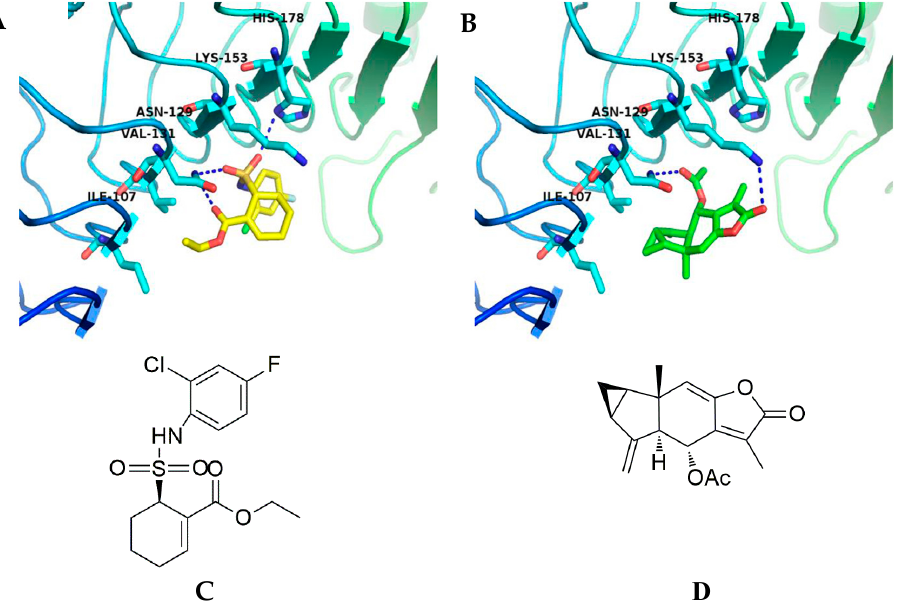
Figure 4. In silico studies to determine binding patterns of TAK-242 or 1 with TLR4. ( A ) TAK-242 (yellow) formed three hydrogen bonds with Asn129 and His178 in the binding site. ( B ) 1 (green) formed two hydrogen bonds with Asn129 and Lys153 in the binding site. Hydrogen bonds are depicted via dashed blue lines. Chemical structures of ( C ) TAK-242 and ( D ) 1 . Docking poses of TAK-242 or 1 were simulated using the crystal structure of the mouse TLR4 protein (PDB: